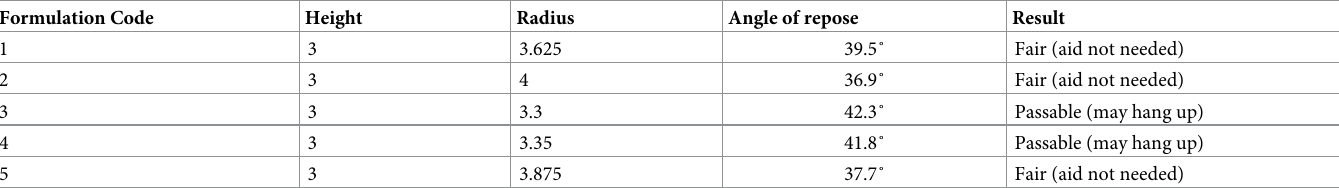
Table 5. Results of the flow properties of the different formulations developed. Formulation Code